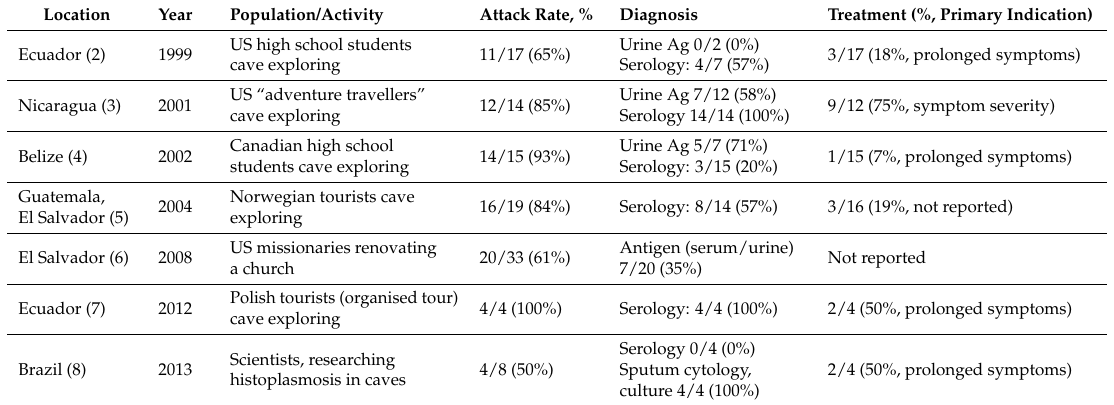
Table 1. Outbreaks of acute pulmonary histoplasmosis in travellers from South and Central America.